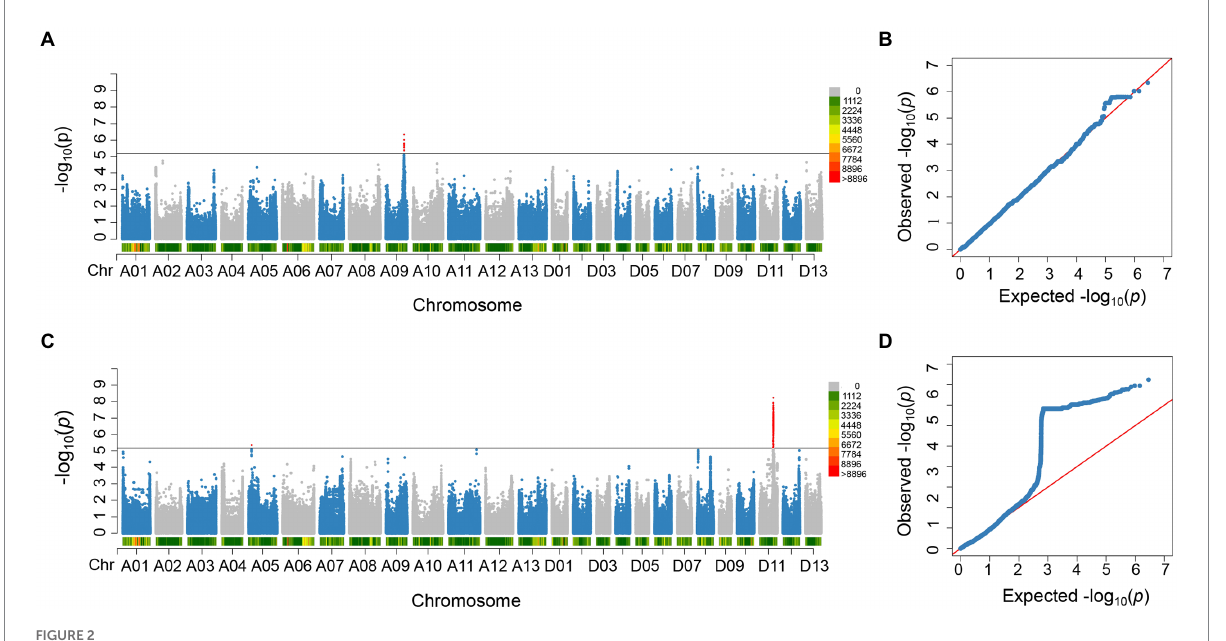
FIGURE 2 Significant SNPs detected in this study. (A) Manhattan plot of the significant SNPs associated with FBA on chromosome A09 in E3_E4_BLUP. (B) QQ plot of significant SNPs associated with FBA on chromosome A09. (C) Manhattan plots of the significant SNPs associated with FBA on chromosome D11 in E2. (D) QQ plot of significant SNPs associated with FBA on chromosome